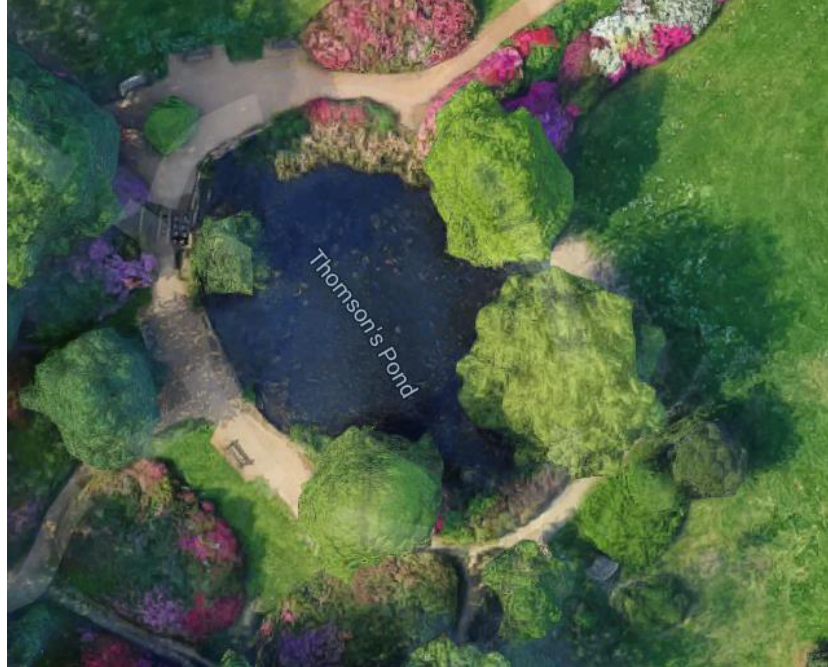
Figure 2. Google Maps view of Thomson’s Pond with an area of open water of approximately 439 m 2 . Google (2022) Isabella Plantation, Richmond Park. Available online: http://maps.google.co.uk (accessed on 26 July 2022).